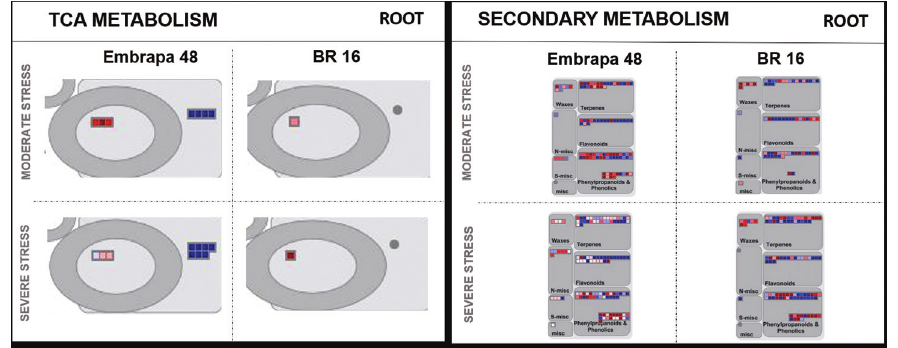
Figure 9 - Metabolism overview mapping (MapMan 3.6 ORC). Genes that were differentially expressed in response to water deficit were mapped to spe- cific stress-related gene groups (TCA and secondary metabolism). The color scale shows the log2 fold-change: red = down-regulated and blue = up-regulated.